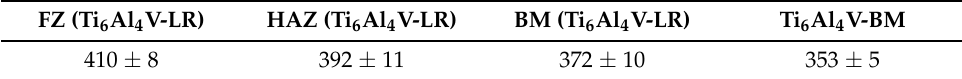
Table 2. Mean and standard deviation of Vickers microhardness (HV 2) of Ti 6 Al 4 V-BM and Ti 6 Al 4 V-LR.